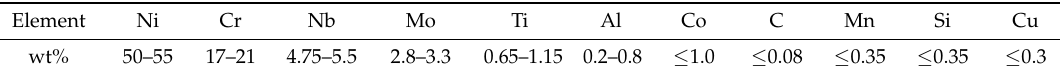
Table 3. The chemical composition of Inconel